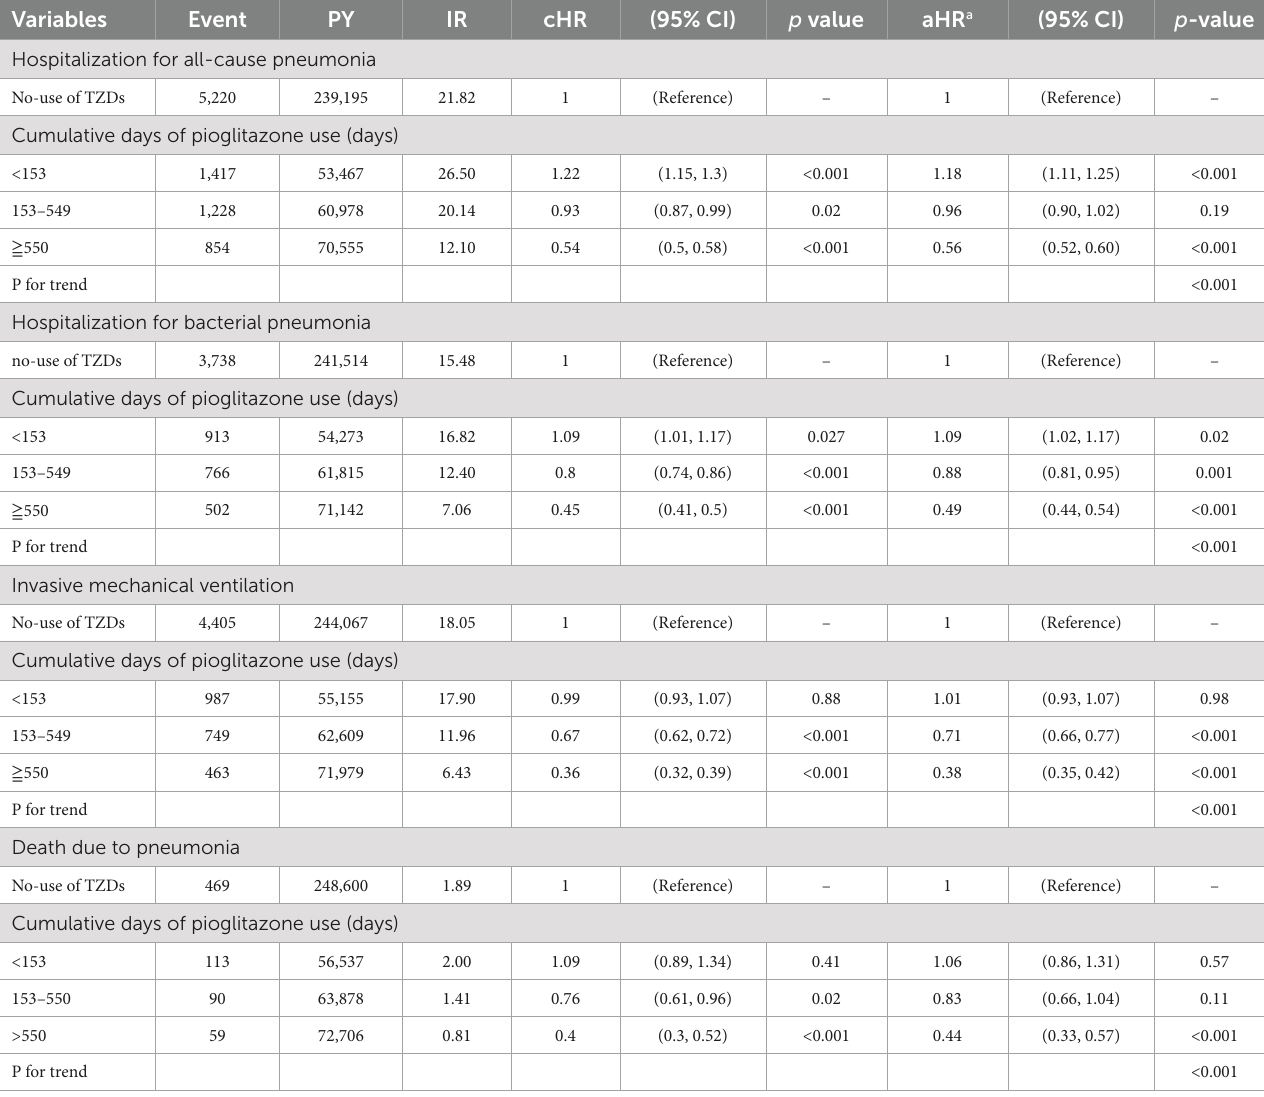
TABLE 4 Hazard ratios and 95% confidence intervals for outcomes with the cumulative duration of pioglitazone